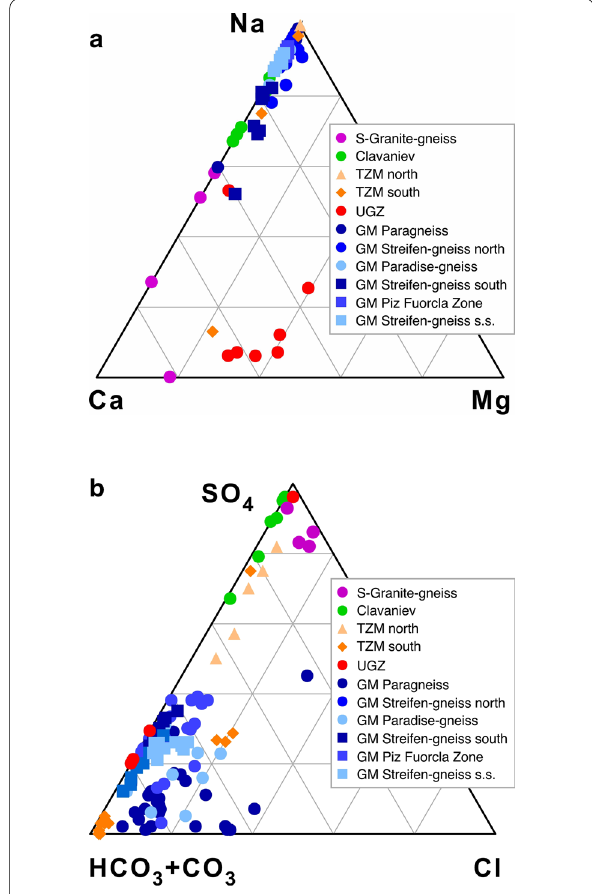
Fig. 6 Major ion concentrations in tunnel inflows shown in % meq L